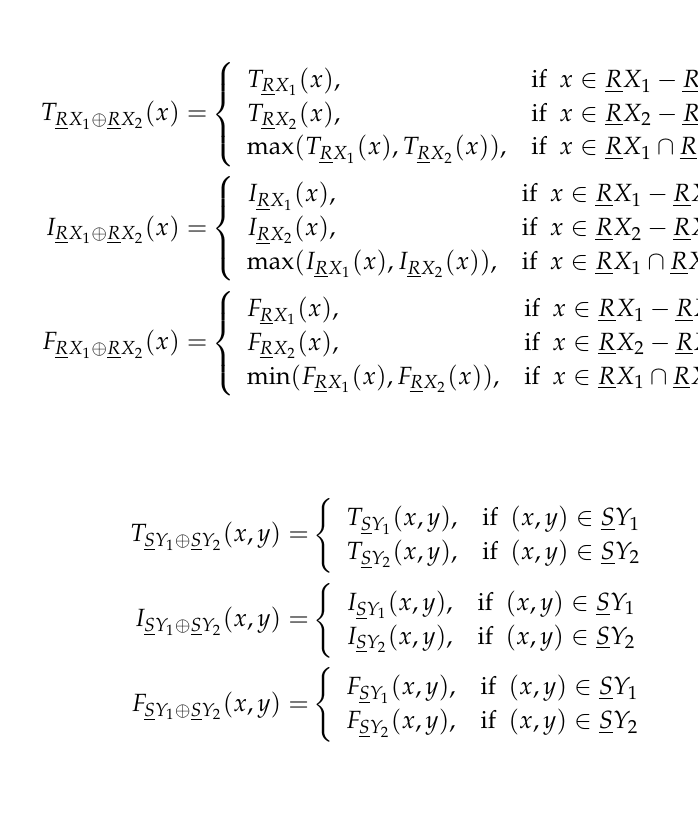
, G 1 ) Figure 3. Regular neutrosophic rough digraph G 1 = ( G 1 , G 1 ) 1